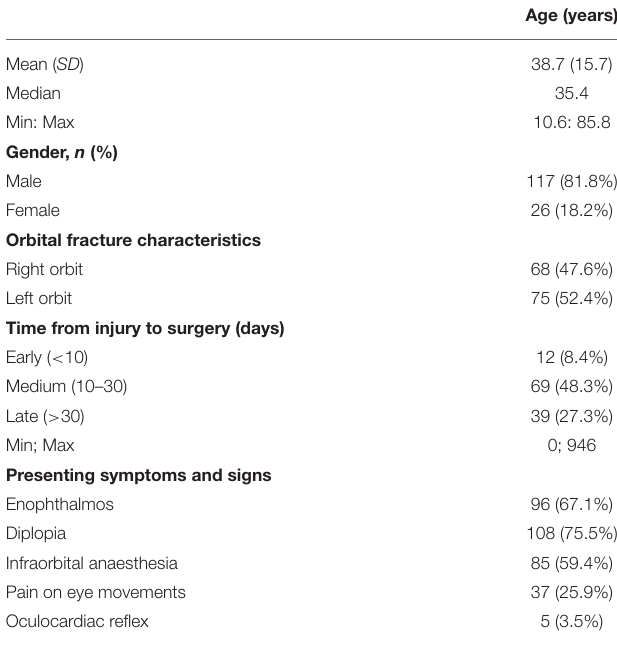
TABLE 1 | Demographics of study patients and presenting